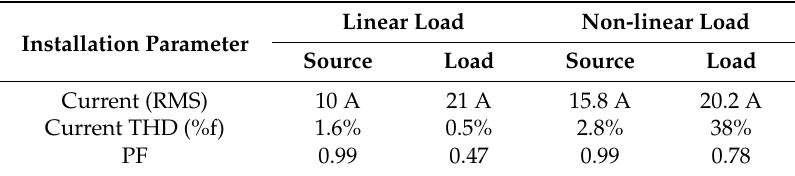
Table 2. Comparison of simulation results of the Root Mean Square (RMS), Total Harmonic Distortion (THD) and power factor (PF) values of the load current and source current with SAPF compensation, for operation with linear and nonlinear loads.